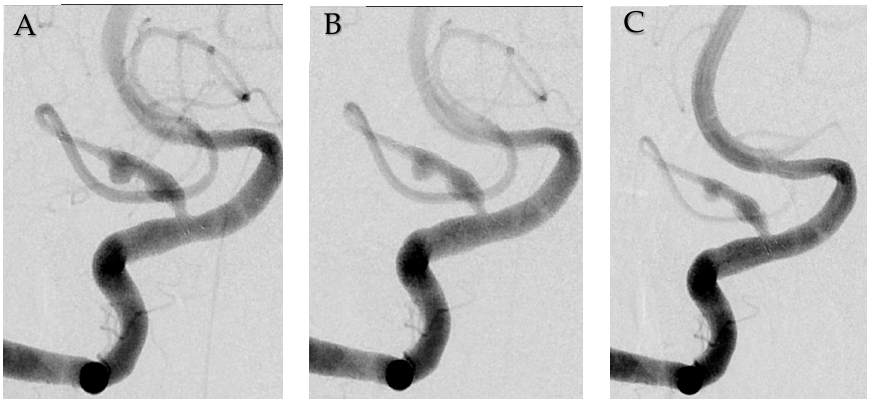
Figure 2. Serial angiogram showing flow diverting effect. Angiogram showed posterior inferior cerebellar artery after single LIVS Jr. 2.5x23 stent deployment ( A ). Immediate angiogram after second LVIS Jr., 2.5x17 stent deployment ( B ). 30 min later, angiogram demonstrated a decreased contrast filling in the dissecting aneurysm ( C